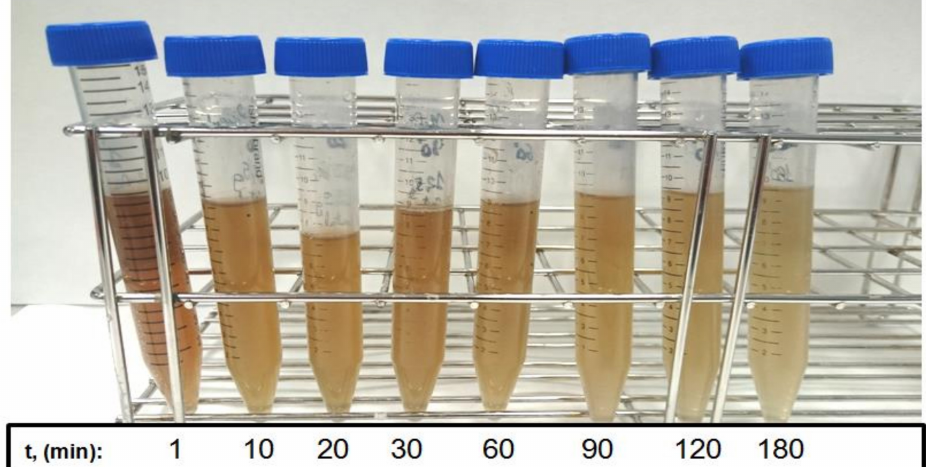
Figure 3. OMW samples after centrifugation taken at different times of photo-Fenton treatment (UV/ HFeO 2 /H 2 O 2 ). Common operating conditions: COD initial = 16586 mg O 2 /L, H 2 O 2 = 35.3 g/L, [HFeO 2 ] = 30 g/L, T = 20 ◦ C, agitation speed = 700 rpm, and pH =